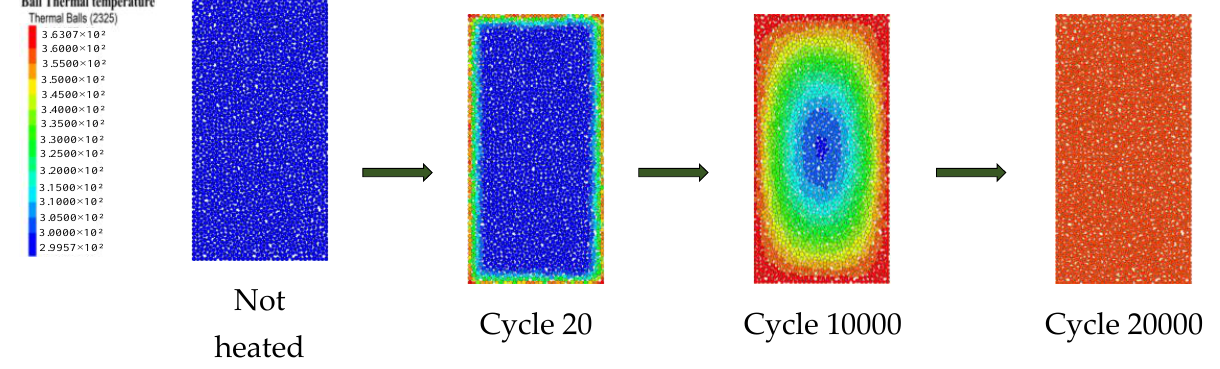
Figure 6. Coal sample heating process.